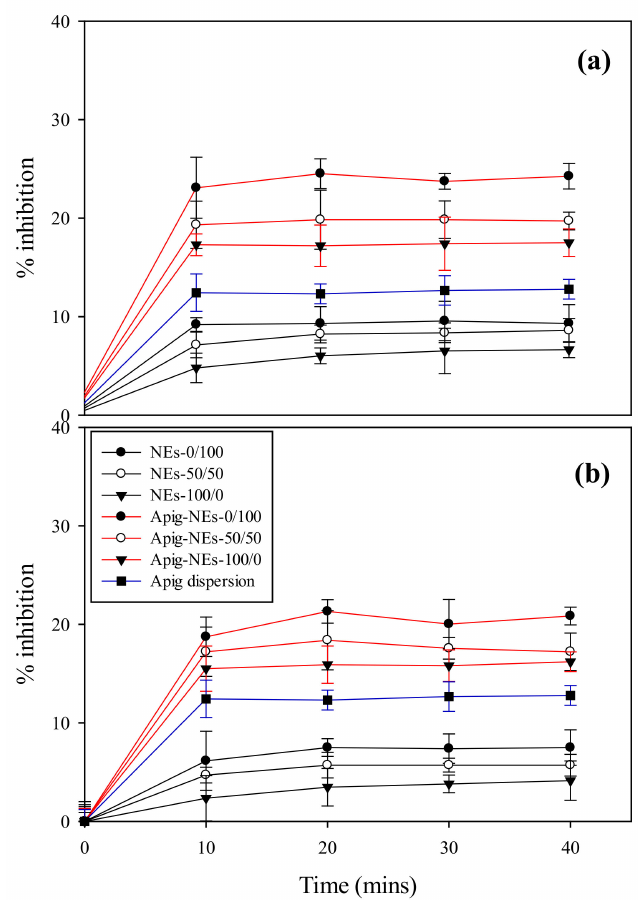
Figure 4. Antioxidant activities of Apig, blank NEs, and Apig loaded ( a ) BSFL oil NEs and ( b ) AV oil NEs with different surfactant ratios of HL/TPGS at SOR 60% and oil content